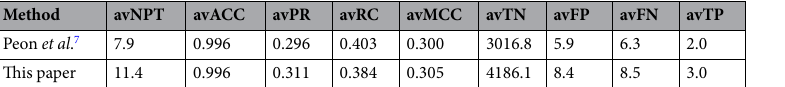
Table 1. Change in test set performance of the same ligand-centric target prediction method depending on the employed knowledge-base. The expanded knowledge-base can be found in the last